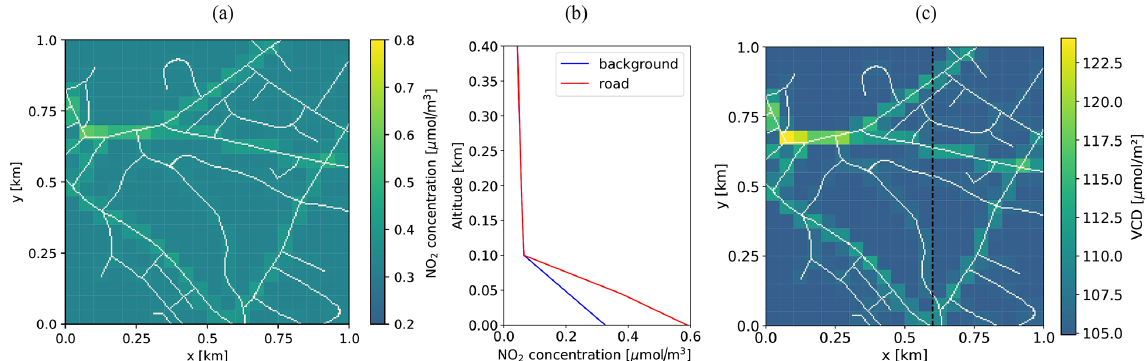
Figure 2. (a) NO 2 ground concentration map. (b) NO 2 vertical profile at a background location (blue line) and over a road at x = 5, y = 55m (red line). (c) Field of vertically integrated NO 2 column densities (VCD) with aircraft flight track overlaid as dashed black line.